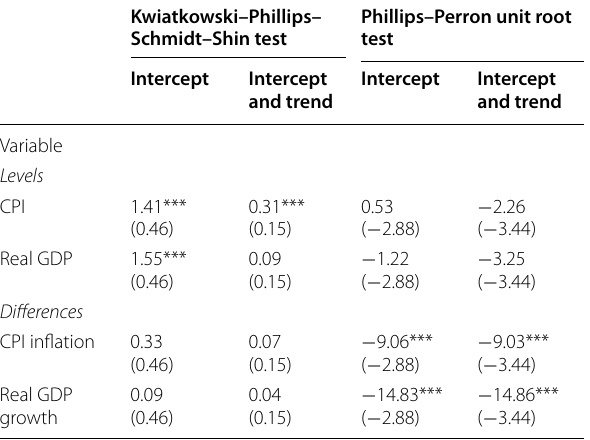
Table 1 Average real GDP growth and inflation Subperiod Real GDP growth